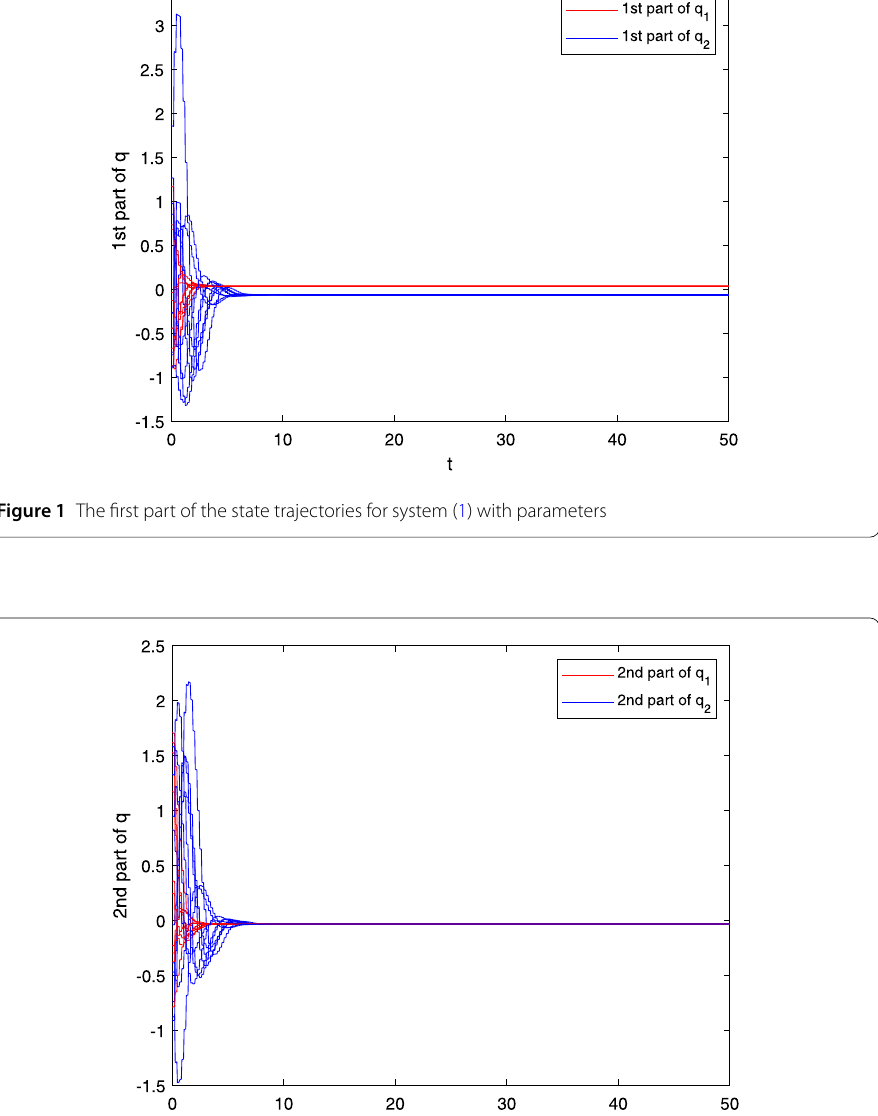
work involves the Hopf bifurcation of a fractional-order octonion-valued neural networks with time delay [34]. This important work is a substantial extension of traditional integer- order neural networks, which provide us a new way to extend our work. Note that, in references [33] and [34], to obtain the corresponding results, the authors transform their QVNNs into several RVNNs or CVNNs from research methods. In this article, we obtain the dynamical behaviors of QVNNs directly using the basic properties of QVNNs, instead of converting them into complex- or real-valued system, which avoids the increase of sys- tem